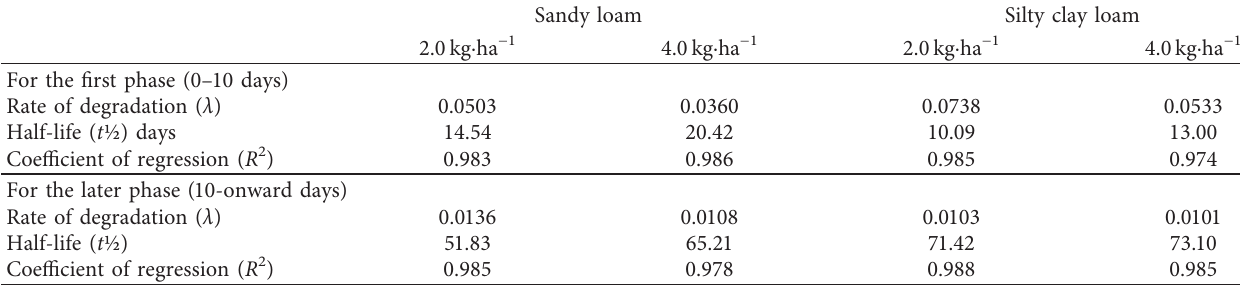
Table 2: Coefficients of determination ( R 2 ), rate of degradation, and half-life for different doses of